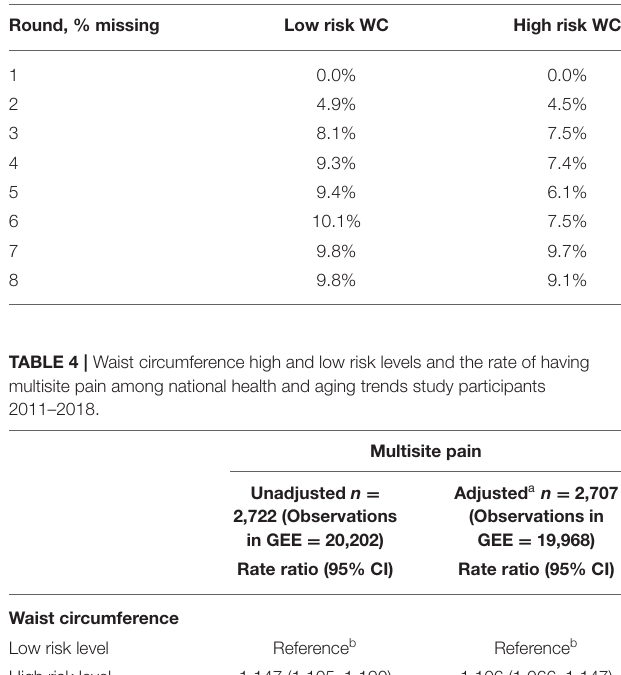
TABLE 2 | 2011 baseline characteristics of national health and aging trends study participants by waist circumference (WC) risk level, for study of central adiposity and pain.